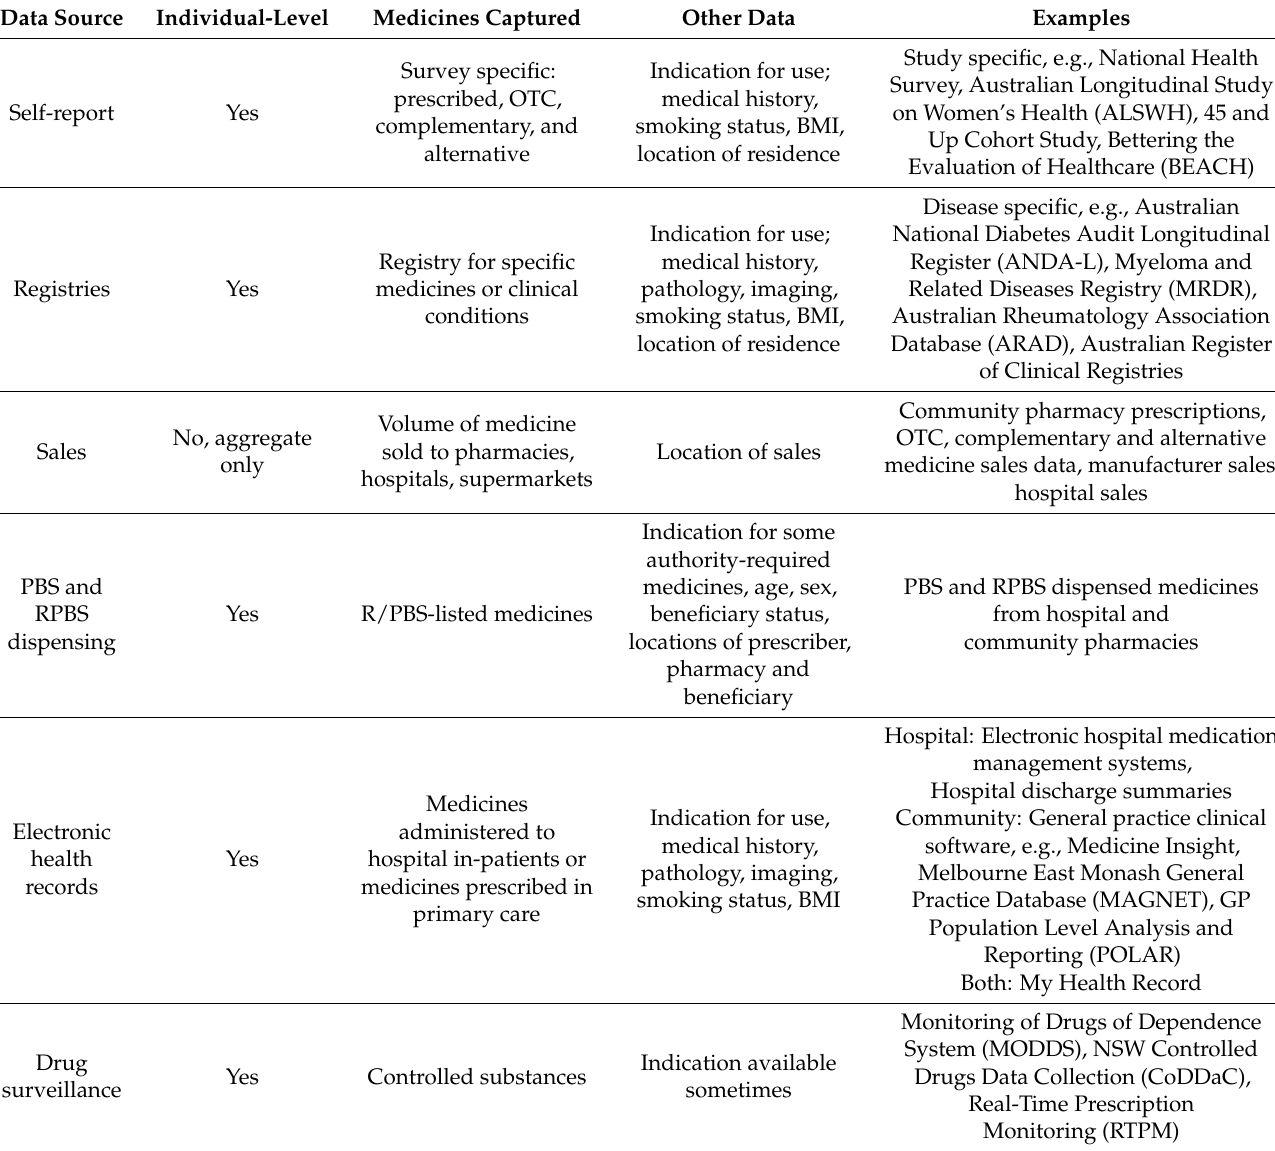
Table 1. Data sources estimating individual and population-level medicine use in